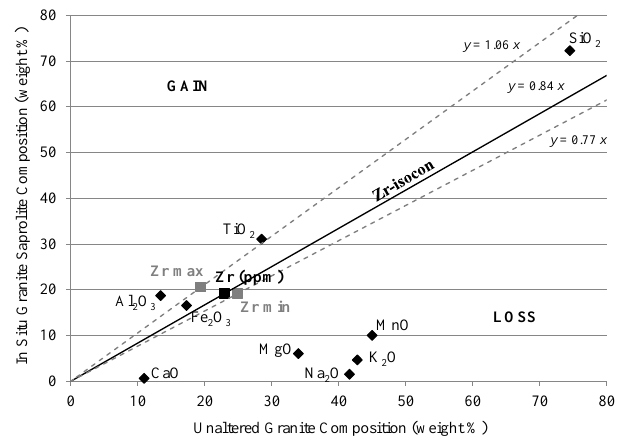
Figure 6. Comparison of element concentrations of the in situ granite saprolite (median of 3 analyses) and the unaltered granite (Hergt et al., 2007) from the study site (determined by X-ray fluorescence (XRF) analysis). Zr (as ppm) is assumed to be immobile and an isocon (Grant, 1986; Webb and Golding, 1998) is defined from the origin through this point. Above this line the granite saprolite is enriched in that element, below the line it is depleted. Minimum and maximum isocons are defined by the equivalent Zr ratios from both sets of analyses. In order to better show some elements visually on this graph both values were multiplied by 10, 100 or 1000. As these are ratios, so long as both values have the same multiplication applied to them, the result is not affected.